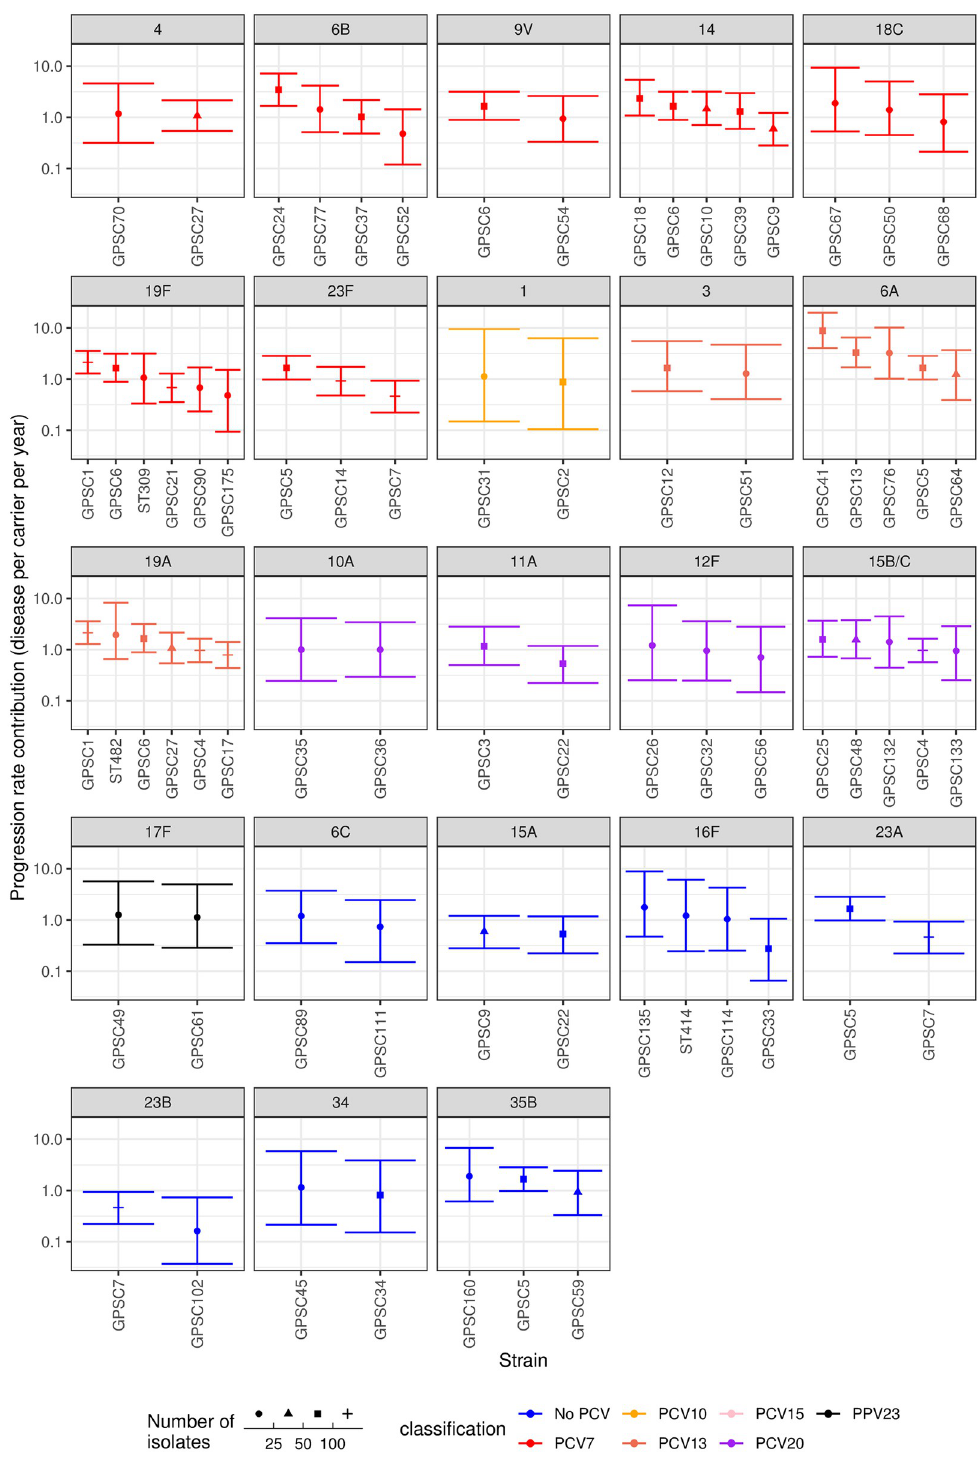
Fig 6. Estimates of the coefficient by which strains modify the invasiveness of their expressed serotype, inferred from genotyped isolates using the study-adjusted type-determined strain-modified model. Strains are arranged by the serotypes with which they are associated. Data are only shown for serotypes found in multiple serotype-strain combinations, each represented by at least ten isolates across the included studies. Points represent the median estimate, and are coloured by the vaccine formulations in which the corresponding serotype is present. The error bars represent the 95% credibililty intervals. The shape of the point represents the sample size on which the estimate is based.